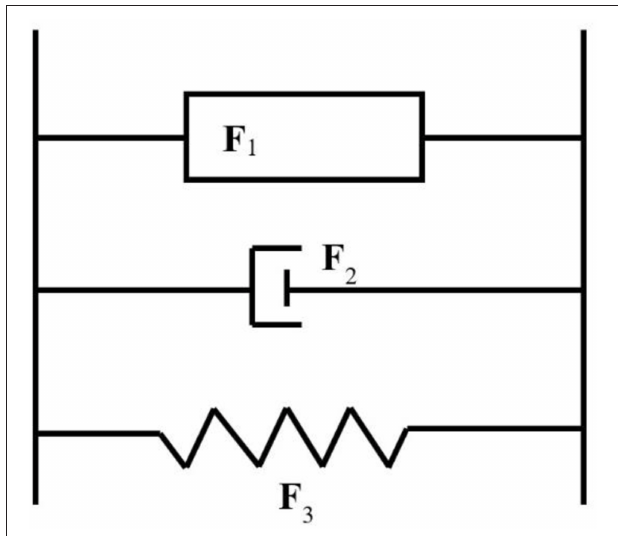
FIGURE 4 | The Bingham phenomenological